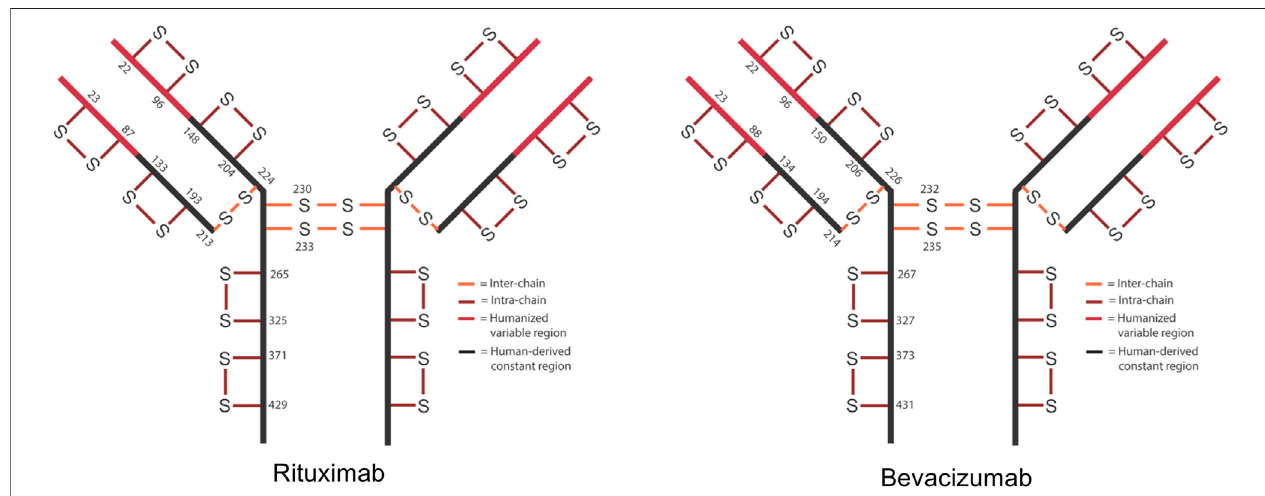
FIGURE 1 | Schematic of expected disul fi de bond locations for rituximab and bevacizumab. Fc region is shown in black and Fv region is shown in red. 12 intra- chain (red) and 4 inter-chain (orange) bonds are typical for IgG1.